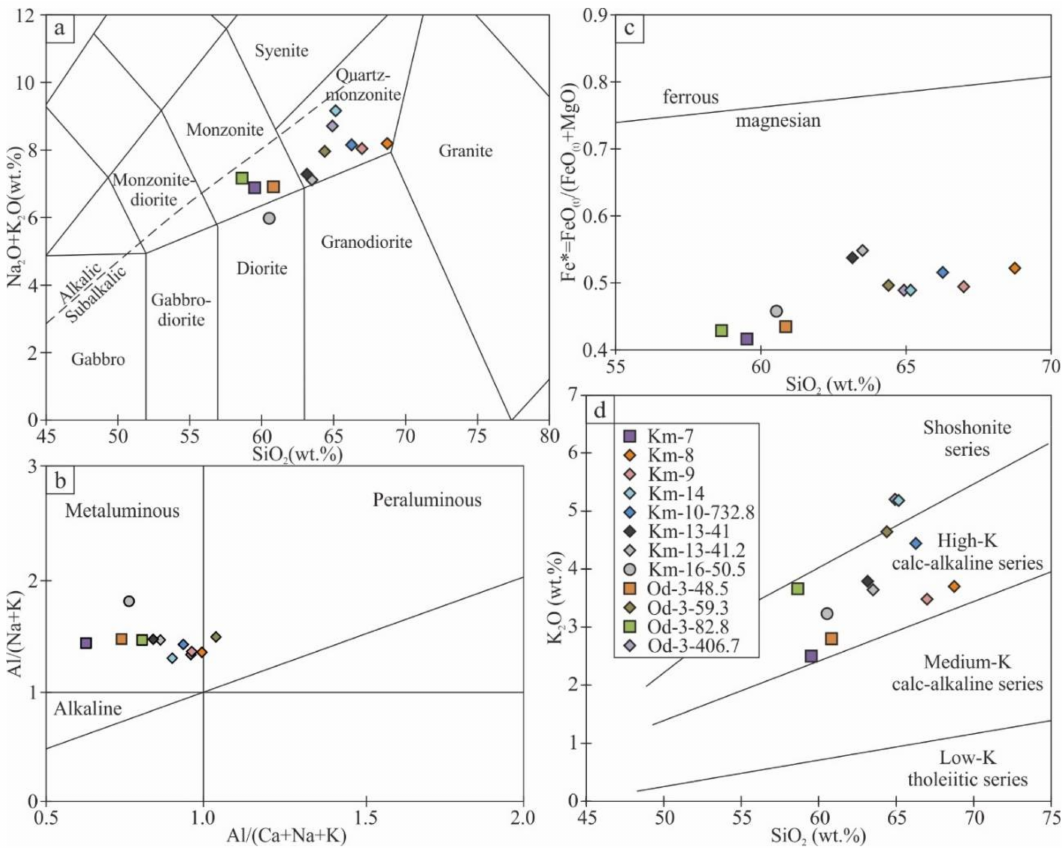
Figure 4. Classification diagrams illustrating the chemistry of igneous rocks from the Kultuma deposit area. ( a ) SiO 2 vs. (K 2 O + Na 2 O) diagram for chemical compositions of intrusive rocks (after [28,29]); ( b ) molar Al/(Na + K) vs. Al/(Ca + Na + K) diagram defining alkaline, meta-aluminous and peraluminous igneous rocks [30]; ( c ) Fe* vs. SiO 2 diagram showing the boundary between ferroan plutons and magnesian plutons [31]; ( d ) SiO 2 vs. K 2 O diagram